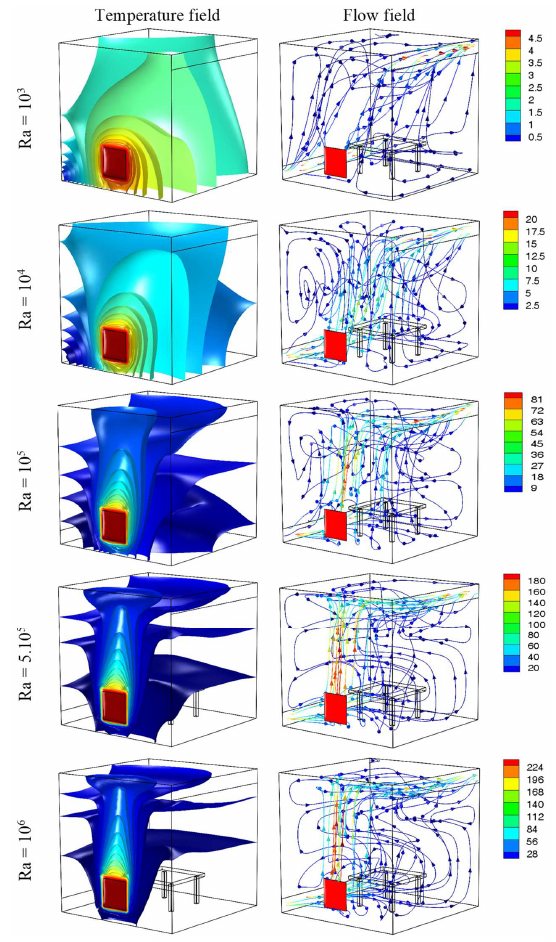
Figure 8. Effect of Rayleigh number variation on the distribution of temperature iso-surfaces and particle trajectories for a heat source position as indicated in case 4. The temperature fields and flow structure for the case of bottom heating (case 5) are presented in Figure 9. The isotherm profile shows a thermal stratification between the heat source and the air inlet opening for low “Ra” values. This stratification becomes isotropic from the heat source for high “Ra” values. The particles trajectory is marked by two dom- inant flow motions when the Rayleigh number is low: the first starting from the air inlet opening, passing through the ground, and then following the wall x = 1 until it reaches the air outlet opening, and the second immediately towards the top of the chamber from the inlet opening. This second flow hits the room roof causing the creation of a rotational cell with a vortex center located in the upper left corner of the room. A slight increase in